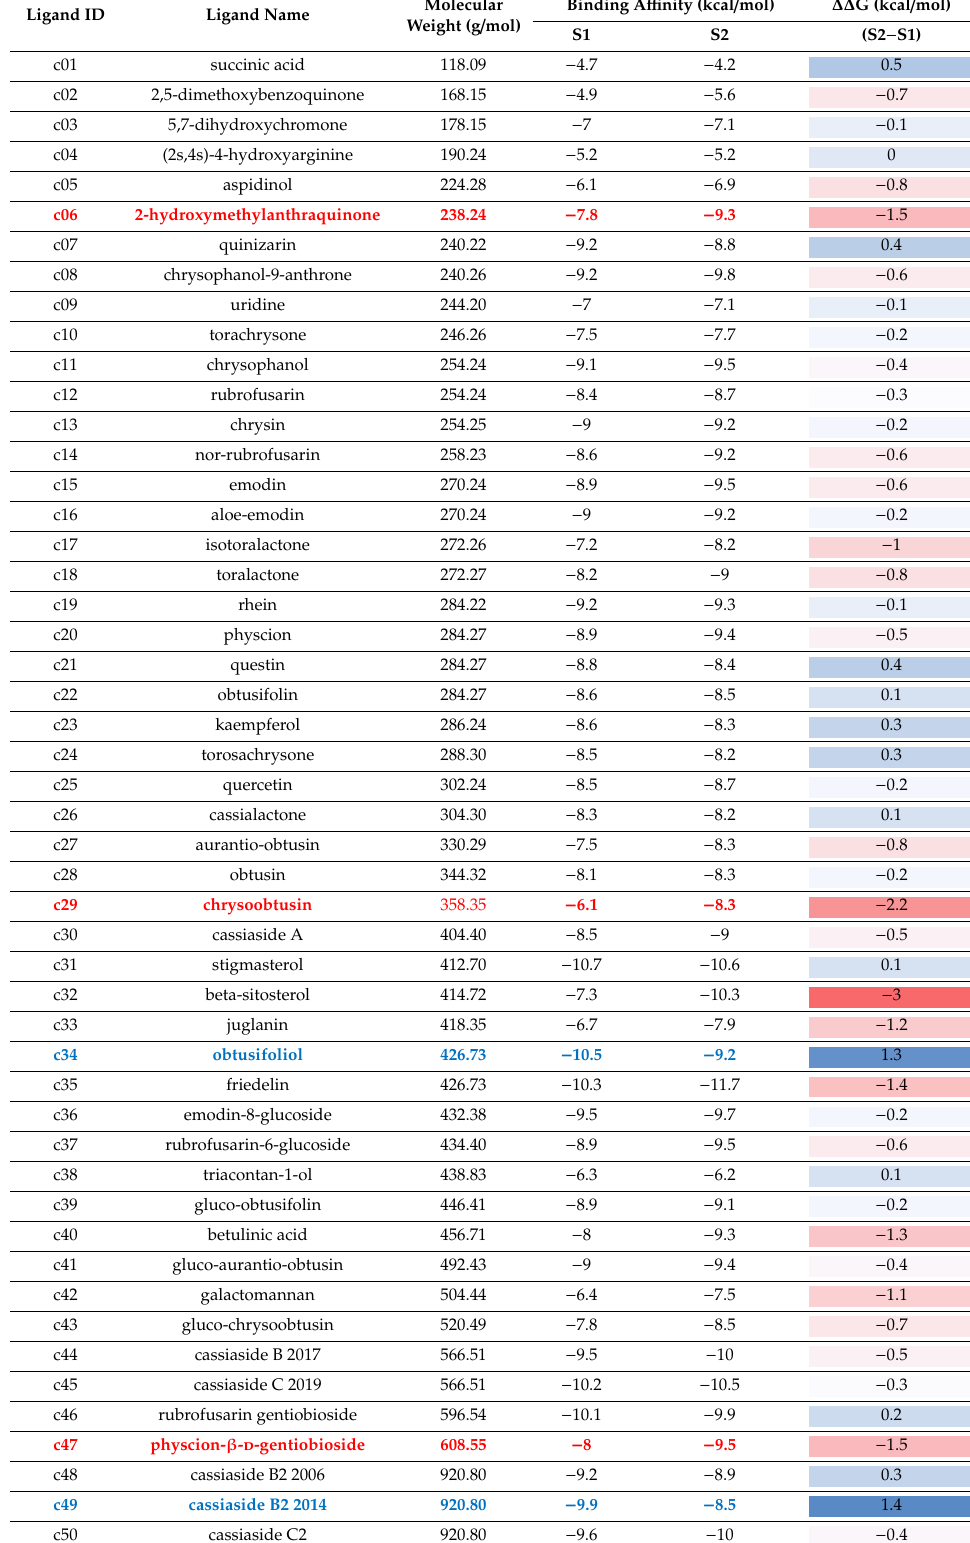
Table 2. Binding a ffi nity and di ff erence in ∆∆ G values between the predicted binding a ffi nity of each Cassiae semen ligand to S1 and S2. Cells for ∆∆ G values are colored using a red-white-blue scheme, with blue indicating most positive values and red most negative. Bolded ligand names are ligands of especial interest, discussed in the